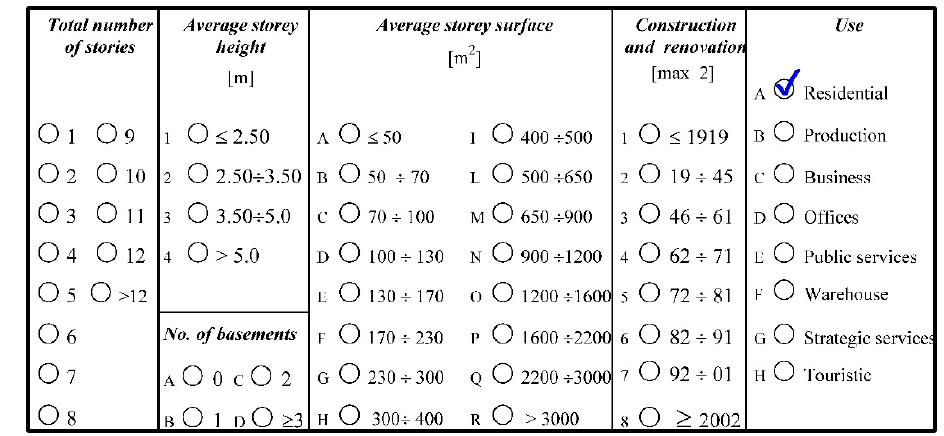
Figure 1. Extract of the AeDES form for building description—adapted from Baggio et al. [4].